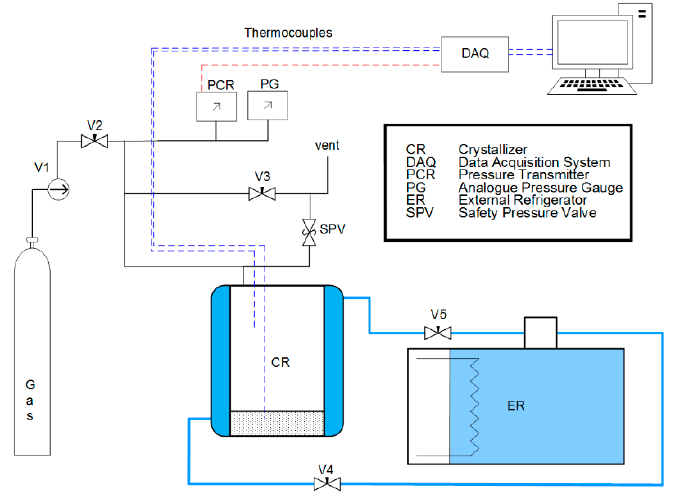
Figure 1. Schematic of the clathrate-hydrate-based desalination apparatus.